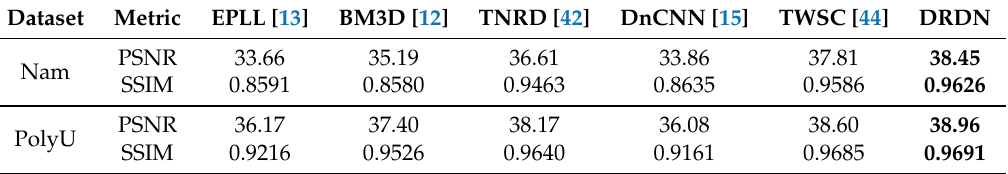
Table 3. Results of real-world denoising on the Nam dataset [29] and the PolyU dataset [30]. Best performance is in